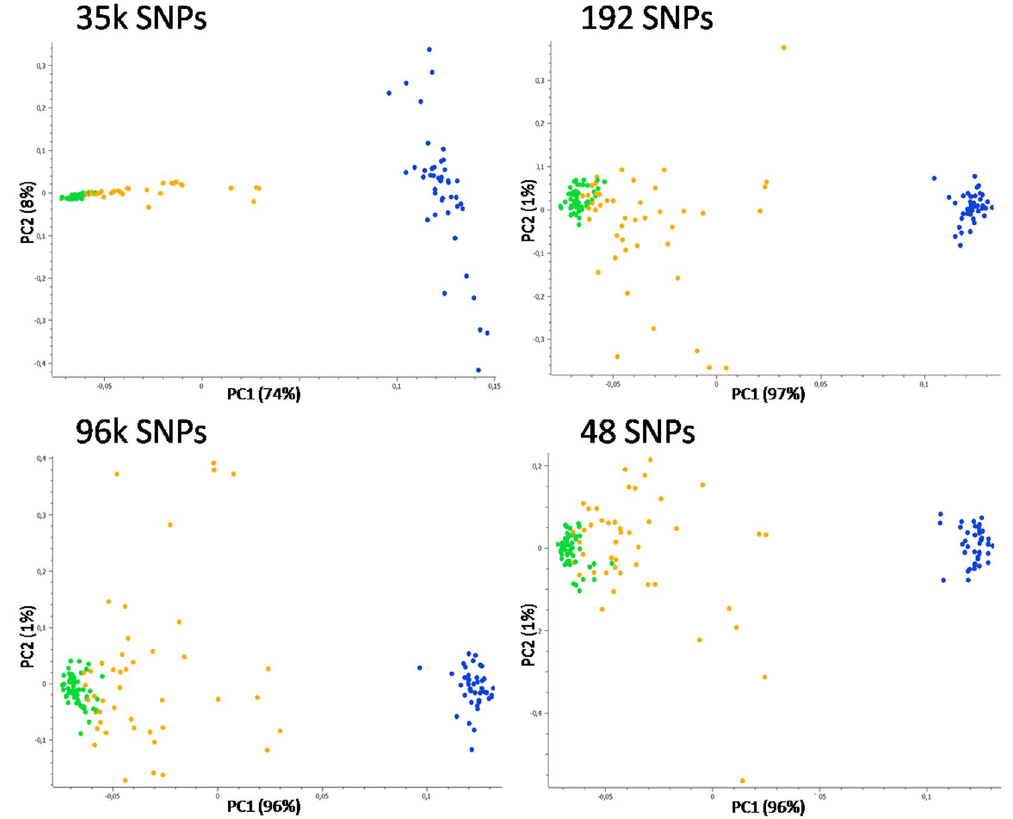
Figure 4. Principal component analysis (PCA) computed in SVS on the 35k LD-pruned SNP panel set and on the 192, 96, 48 SNPs showing the highest wild-domestic cats F ST and I N values. For each dataset, PC1 versus PC2 are indicated (axes are not to scale). Domestic and European wildcats are represented in green and blue dots, respectively, known hybrids and putatively admixed wildcats (Admixture q w < 0.999) in orange. The power of the top 48 SNPs is comparable to that reached with 35k SNPs, indicating that they can be used as reliable ancestry-informative-markers (AIMs), although no clear subdivision could be traced between some of the admixed and the non-admixed